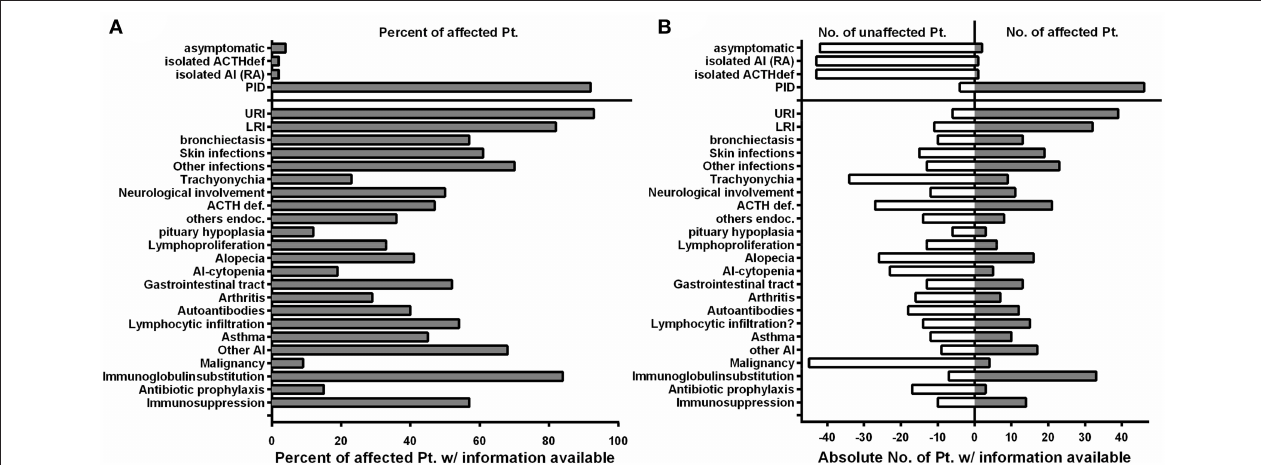
FIGURE 3 | The clinical phenotype in NF- κ B2 haploinsufficiency is characterized by early-onset antibody deficiency, clinical signs of T cell dysfunction, and autoimmunity. (A) Fraction of affected patients relative to the whole cohort of patients of whom information was available with different clinical manifestations depicted on the Y-axis. Manifestations below the solid line are relative to the 46 NFKB2 -mutated patients with PID. (B) Absolute numbers of patients who are not affected by different clinical manifestations are depicted on the left (open white bars), while the absolute number of reported patients affected are depicted to the right side (solid gray